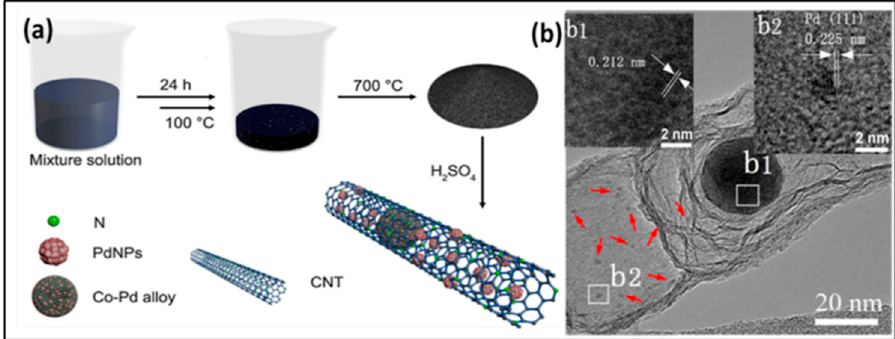
Figure 4. ( a ) Schematic diagram for preparation of Pd-CoCNT; ( b ) HRTEM images of Pd-CoCNT [85].